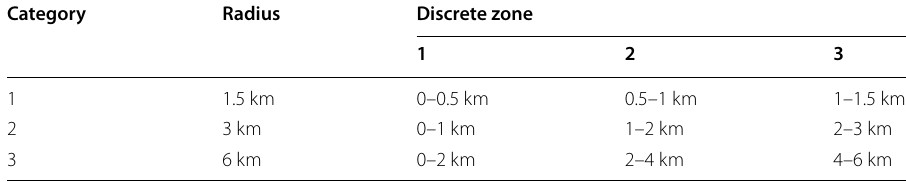
Table 5: Catchment areas according to type of civil registration centre